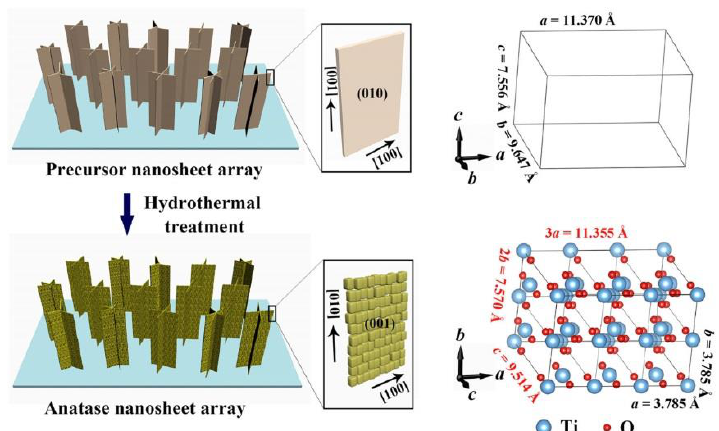
Figure 4. Schematic presentation of topotactic transformation from (010)-faceted precursor nanosheet arrays to (001)-faceted anatase TiO 2 nanosheet arrays on the basis of crystal lattice matchment between orthorhombic precursor crystal and tetragonal anatase crystal. Reprinted with permission from [154]. Copyright Springer, 2017.